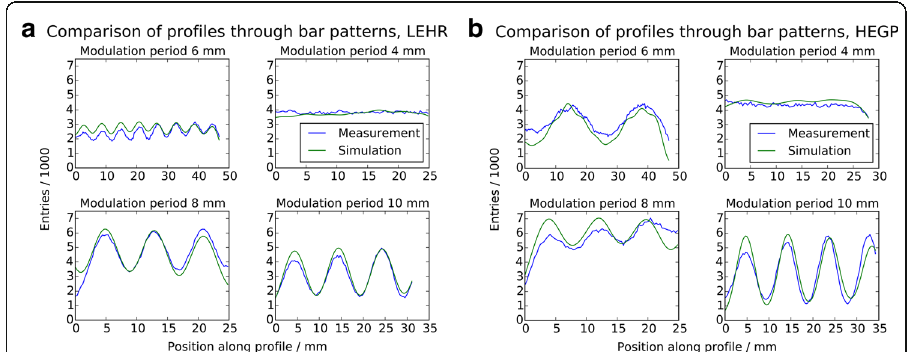
Fig. 7 Profile plots of bar phantom. a Comparison of measured and simulated profiles through the modulation pattern of the bar phantom in the plane setup. b Low-energy, high-resolution collimator; bottom half: high-energy, general-purpose collimator. Simulated results include the spatial resolution model and were normalized to have the same maximum value as the measured